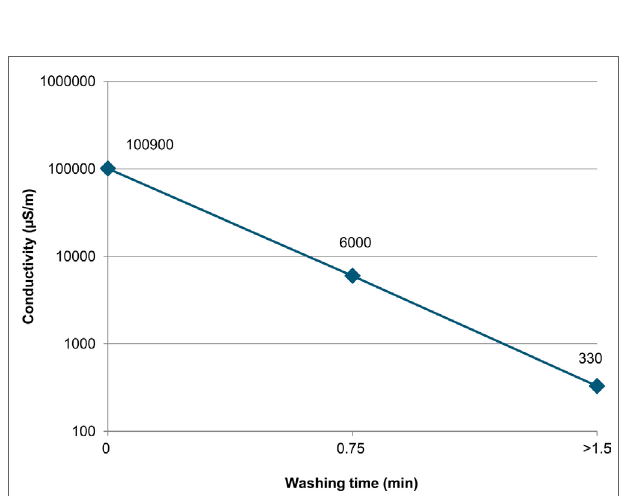
FigUre 6 | Particle size distribution of the solids in the aragonite slurry .